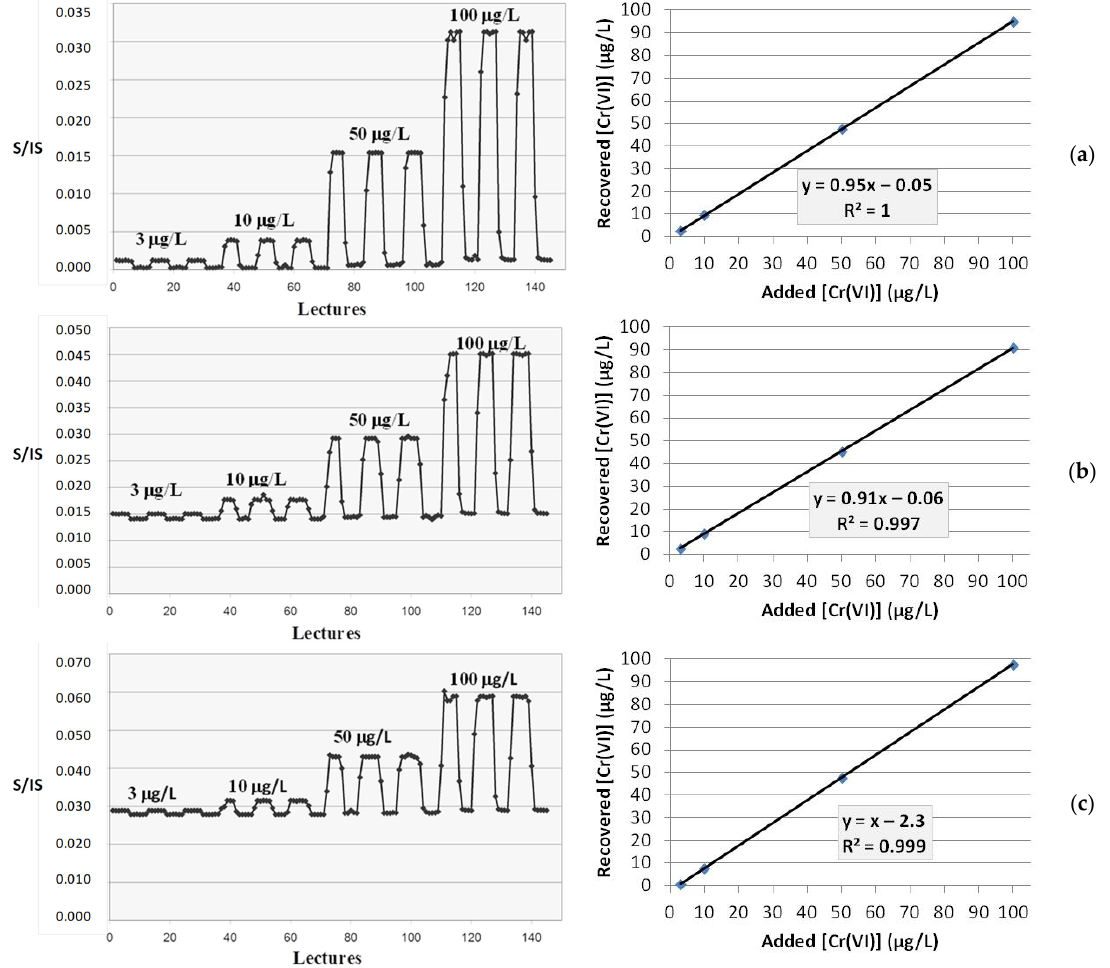
Figure 6. On-line reading of the feed solution containing: ( a ) [Cr(VI)] in the range of 3–100 µg/L in the absence of [Cr(III)]initial; ( b ) [Cr(VI)] in the range of 3–100 µg/L and [Cr(III)] = 50 µg/L; ( c ) [Cr(VI)] in the range of 3–100 µg/L and [Cr(III)] = 100 µg/L.